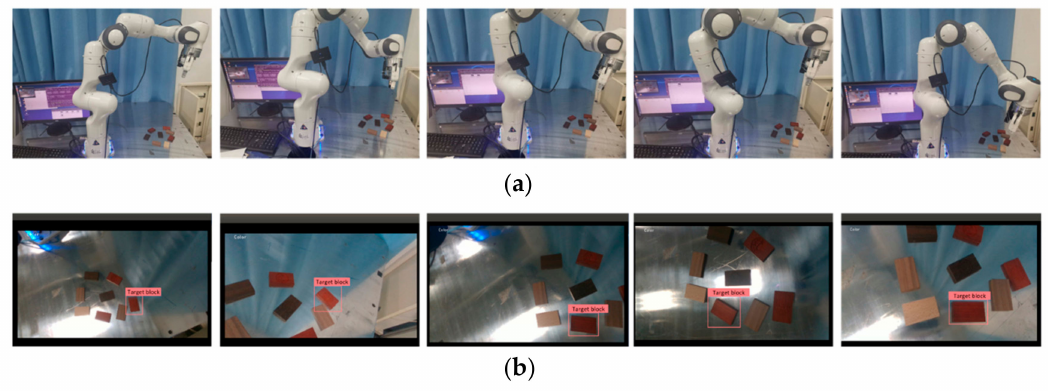
Figure 13. Servo task process of the experiment. ( a ) Relative position of the robot and target at di ff erent times. ( b ) Target recognition situation at the corresponding